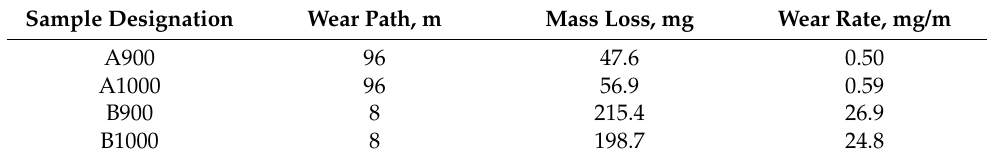
Table 1. Results of abrasive wear tests.